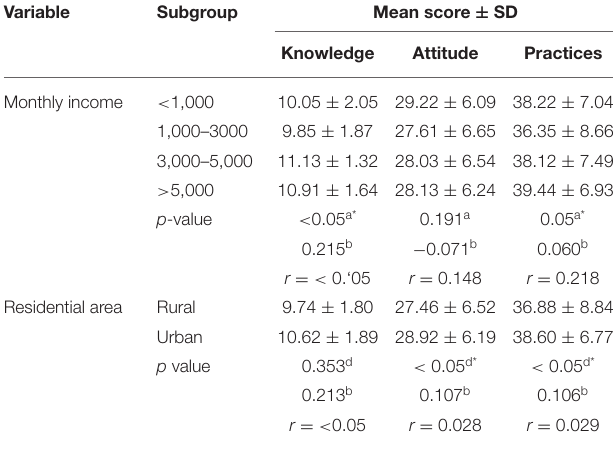
TABLE 1 | Scores between-demographic difference in knowledge, attitudes and